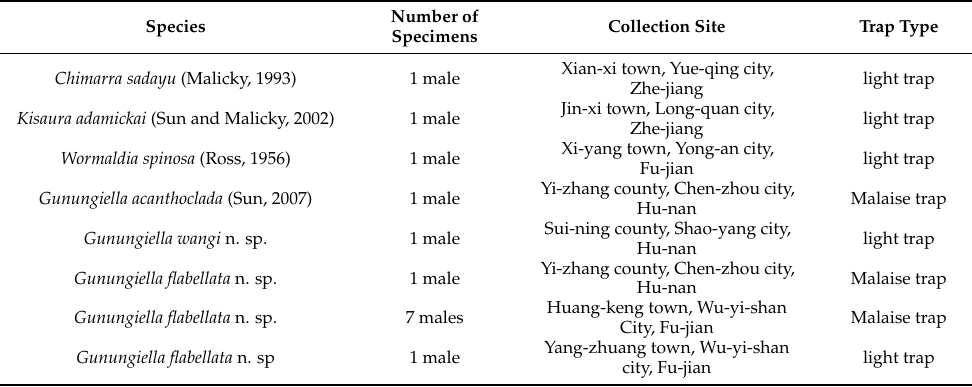
Table 1. Information on the collection of 14